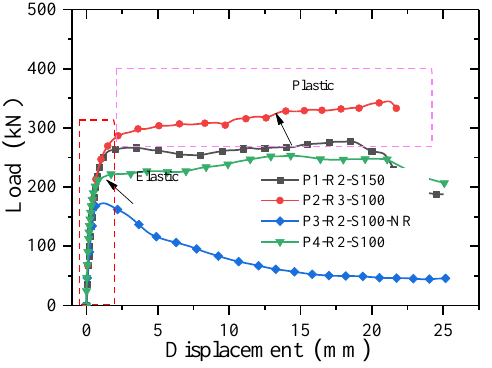
Figure 8. Load–slip curves for the T-type perforated plate connections.